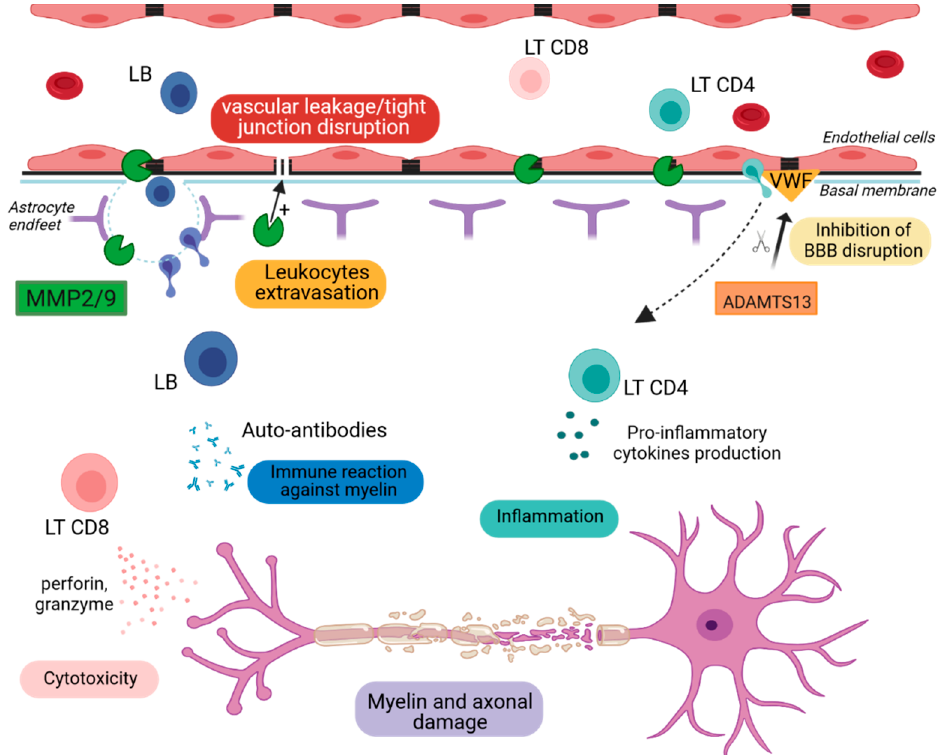
Figure 2. Schematic representation of BBB breakdown. ADAMTS13: A Disintegrin and Metalloproteinase with a Thrombospondin Type 1 Motif, Member 13, MMP2/9: Metalloproteinase-2 and -9, LB: lymphocytes B, LT CD4 + : CD4 T lymphocytes, LT CD8 + : CD8 T lymphocytes, VWF: Von Willebrand factor.